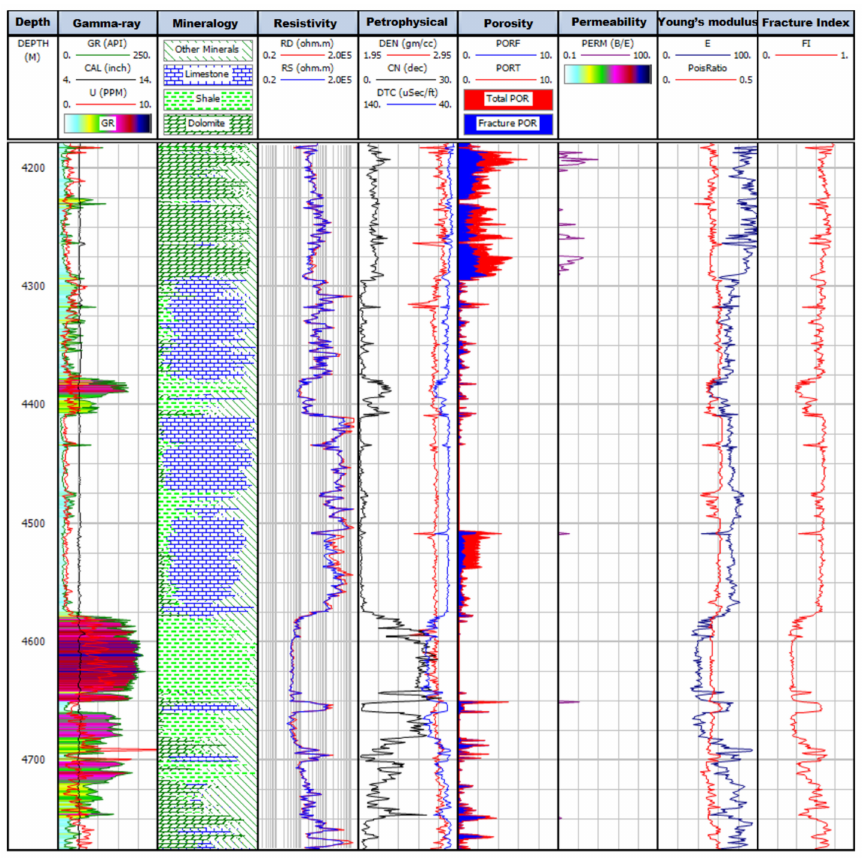
Figure 7. Logging curve of a vertical section of geothermal reservoir in